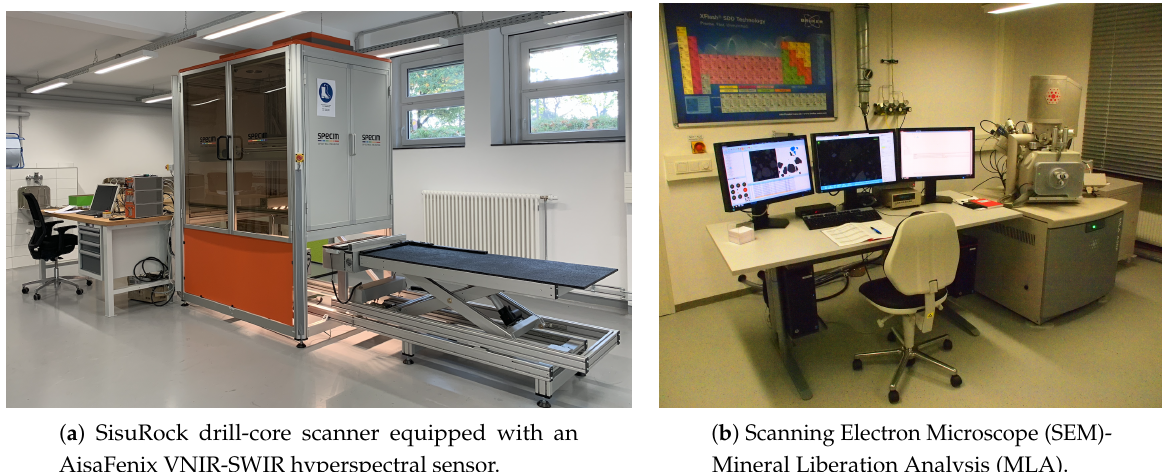
( a ) SisuRock drill-core scanner equipped with an AisaFenix VNIR-SWIR hyperspectral sensor. Figure 3. Drill-core scanner and SEM-MLA instruments available at the spectroscopy and geometallurgy laboratories, respectively, at the Helmholtz Institute Freiberg for Resource